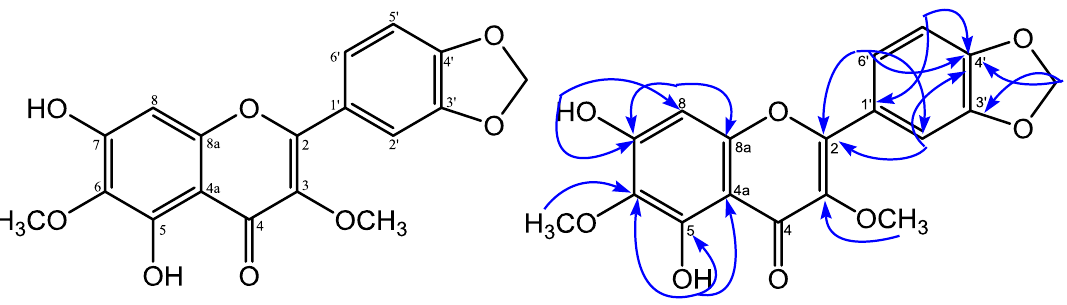
Figure 1. Structure and selected HMBC correlations for 5,7-dihydroxy-3,6-dimethoxy-3′,4′- methylenedioxyflavone.